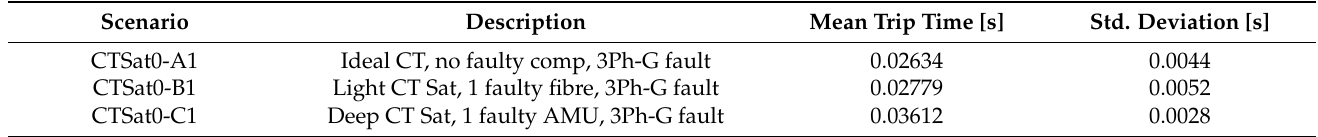
Table 4. Trip times for CTSat0 test case group 1–3-phase-to-ground fault.